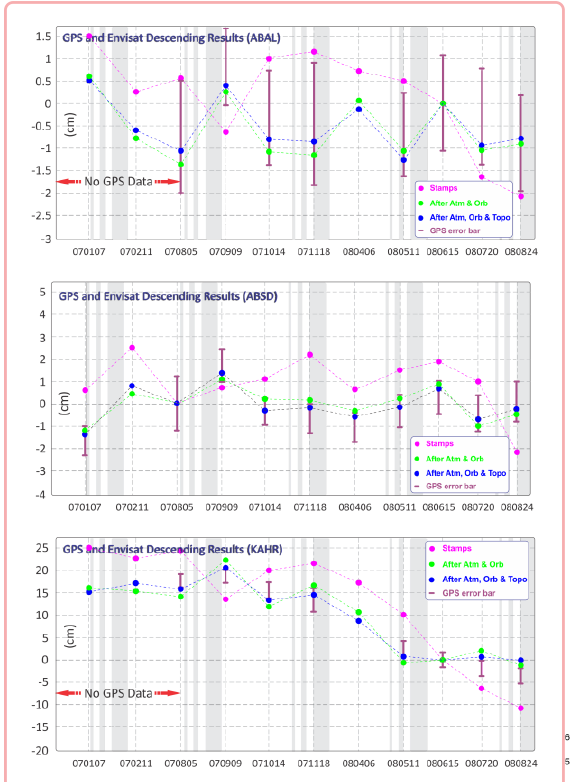
Figure 5: Comparison between GPS measurements and Envisat ascending observations, projected on line of sight for four stations, by Stamps method (magenta), after atmospheric and orbit correction (green) and after topographic, atmospheric and orbital correction (blue).